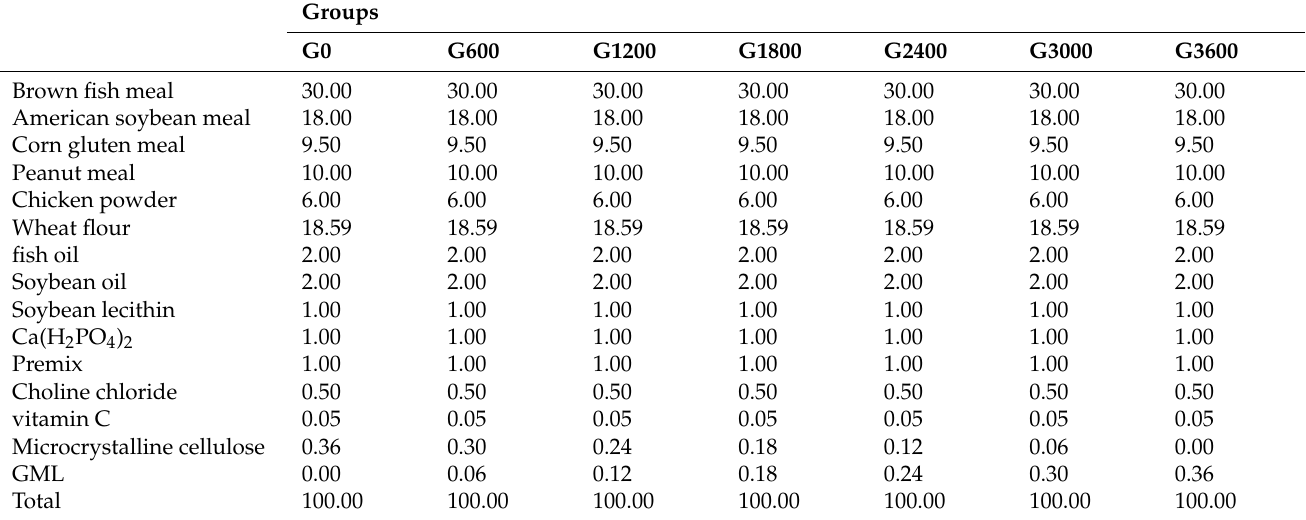
Table 1. Ingredients and chemical compositions of experimental diets (% DM